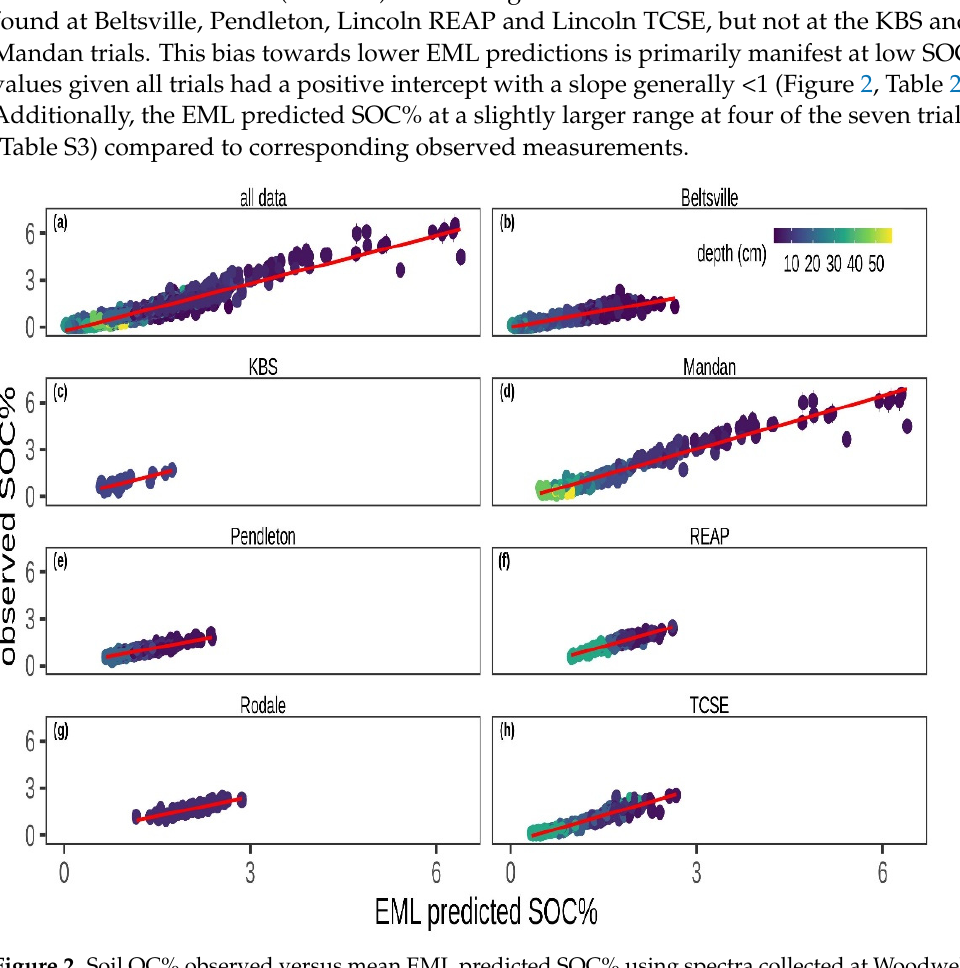
Figure 2. Soil OC% observed versus mean EML predicted SOC% using spectra collected at Woodwell for ( a ) all trials combined, ( b ) Beltsville, ( c ) KBS, ( d ) Mandan, ( e ) Pendleton, ( f ) Lincoln-REAP, ( g ) Rodale, and ( h ) Lincoln-TCSE. The LTR data are all observations across years, treatments, and depths (Table 1). Symbols are color coded by observation sample depth. Results of linear model fits (red lines) are found in Table 2. All slopes are significantly different from 1, except h) TCSE ( p = 0.79). Vertical lines are 95% confidence intervals for EML predictions. Confidence intervals are tight at low SOC% and not visible across most plotting symbols.